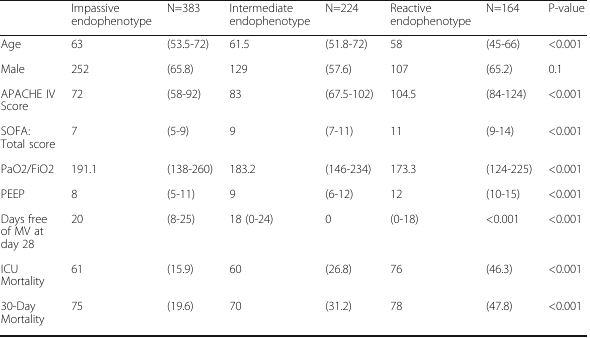
Table 1 (abstract A1). Endophenotypes versus clinical characteristics Impassive endophenotype